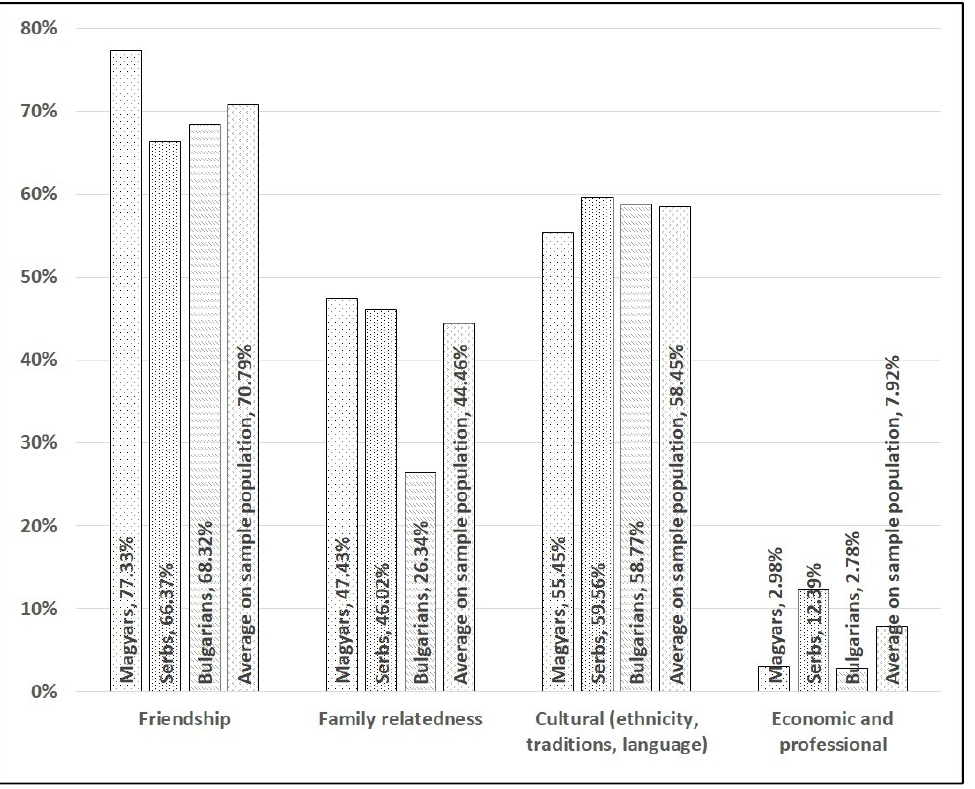
Figure 4. Types of connections between members of ethnic minority communities (Hungarians, Serbs, Bulgarians) in Timi ș County with their country of origin, grouped by area of interest (percentages of mentions by respondents).